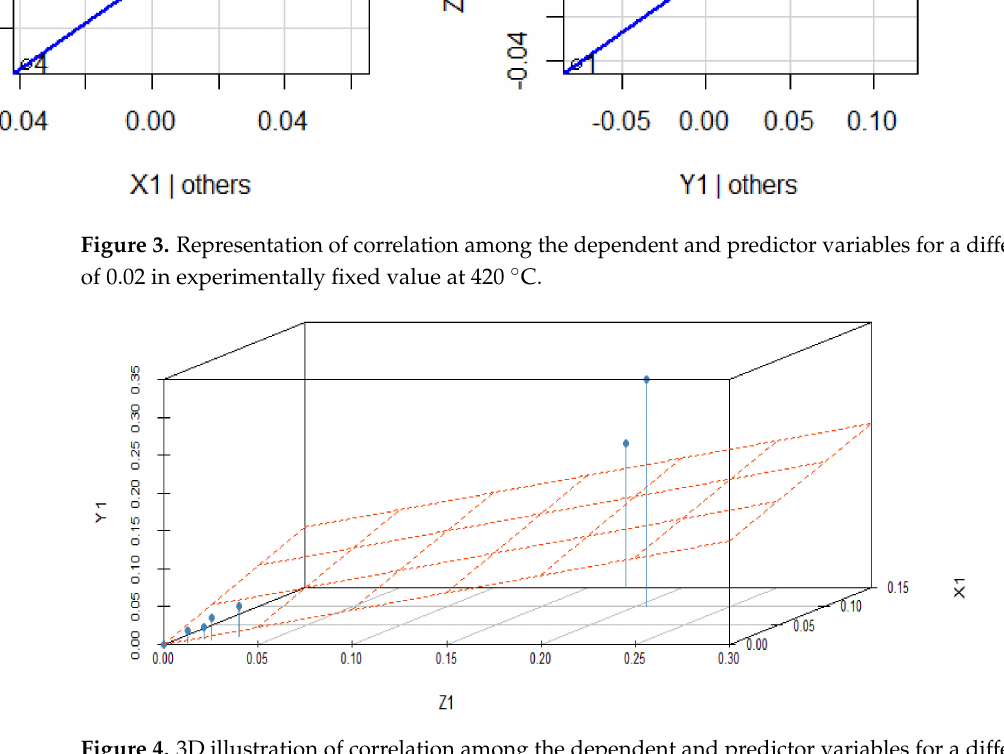
Figure 4. 3D illustration of correlation among the dependent and predictor variables for a difference of 0.02 in experimentally fixed value at 420 ◦